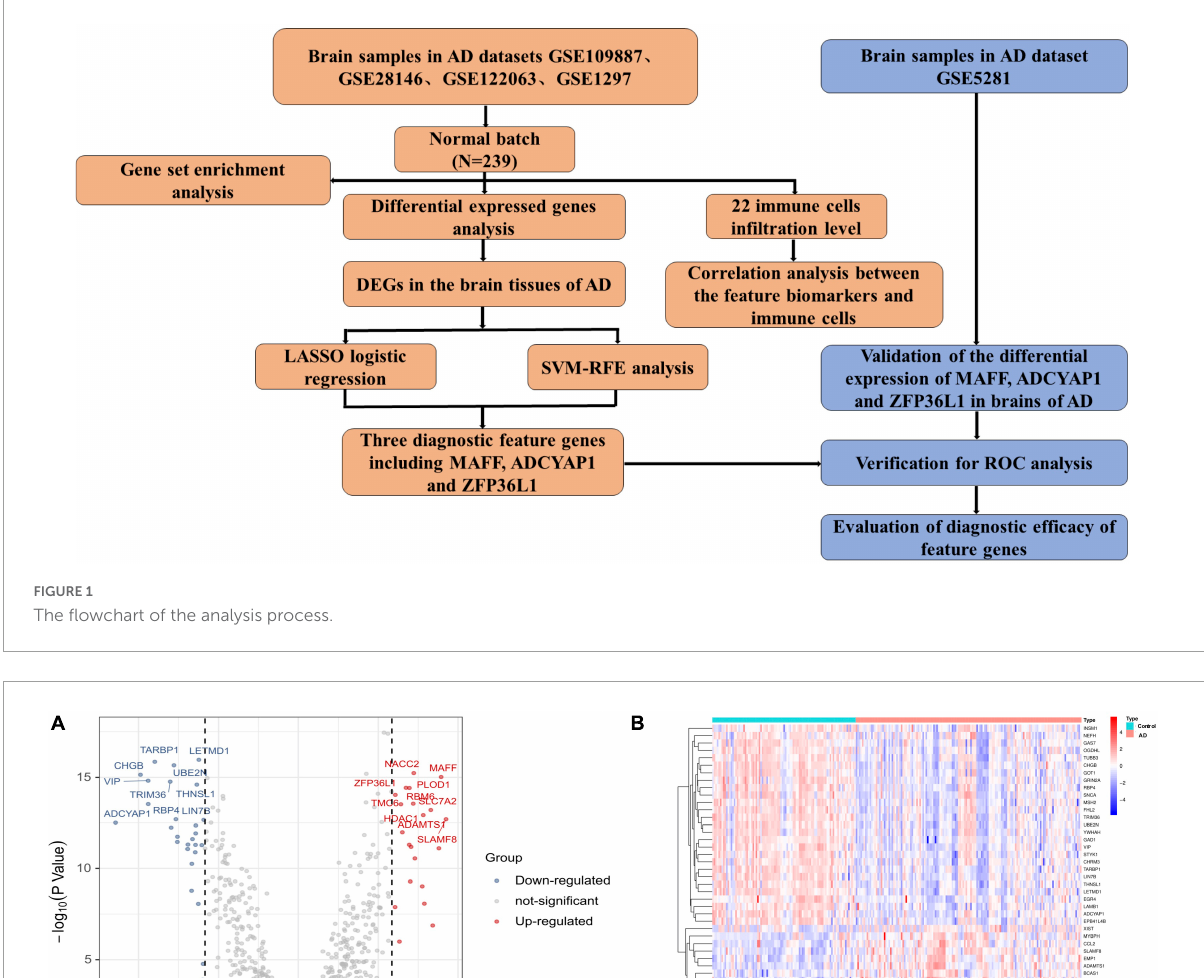
FIGURE2 Differentially expressed genes (DEGs) identified between Alzheimer’s disease and control brain tissues. (A) Volcano plot. (B)